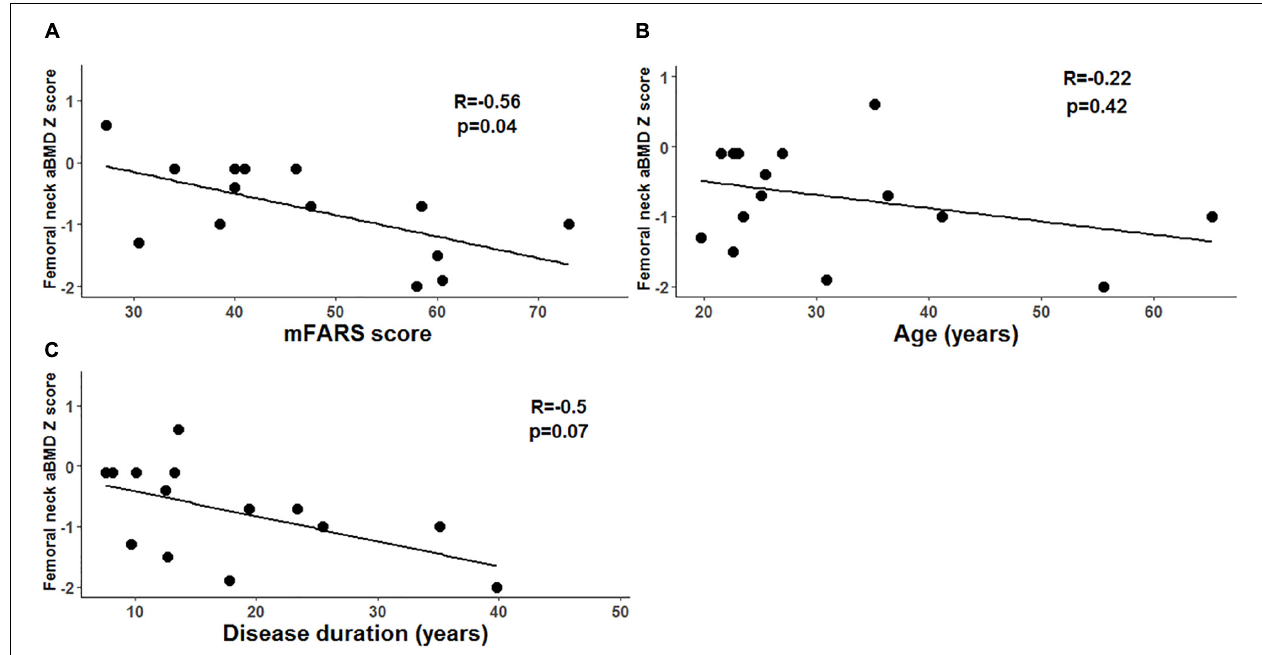
FIGURE 2 | Femoral neck areal bone mineral density (aBMD) and markers of disease severity in adults with Friedreich’s ataxia (FRDA). (A) In adults with FRDA, mFARS scores (higher scores indicate more severe disease) are negatively correlated with femoral neck aBMD Z-scores. (B) We did not detect a correlation between disease duration and femoral neck aBMD Z scores. (C) We did not detect a correlation between age and femoral neck aBMD Z